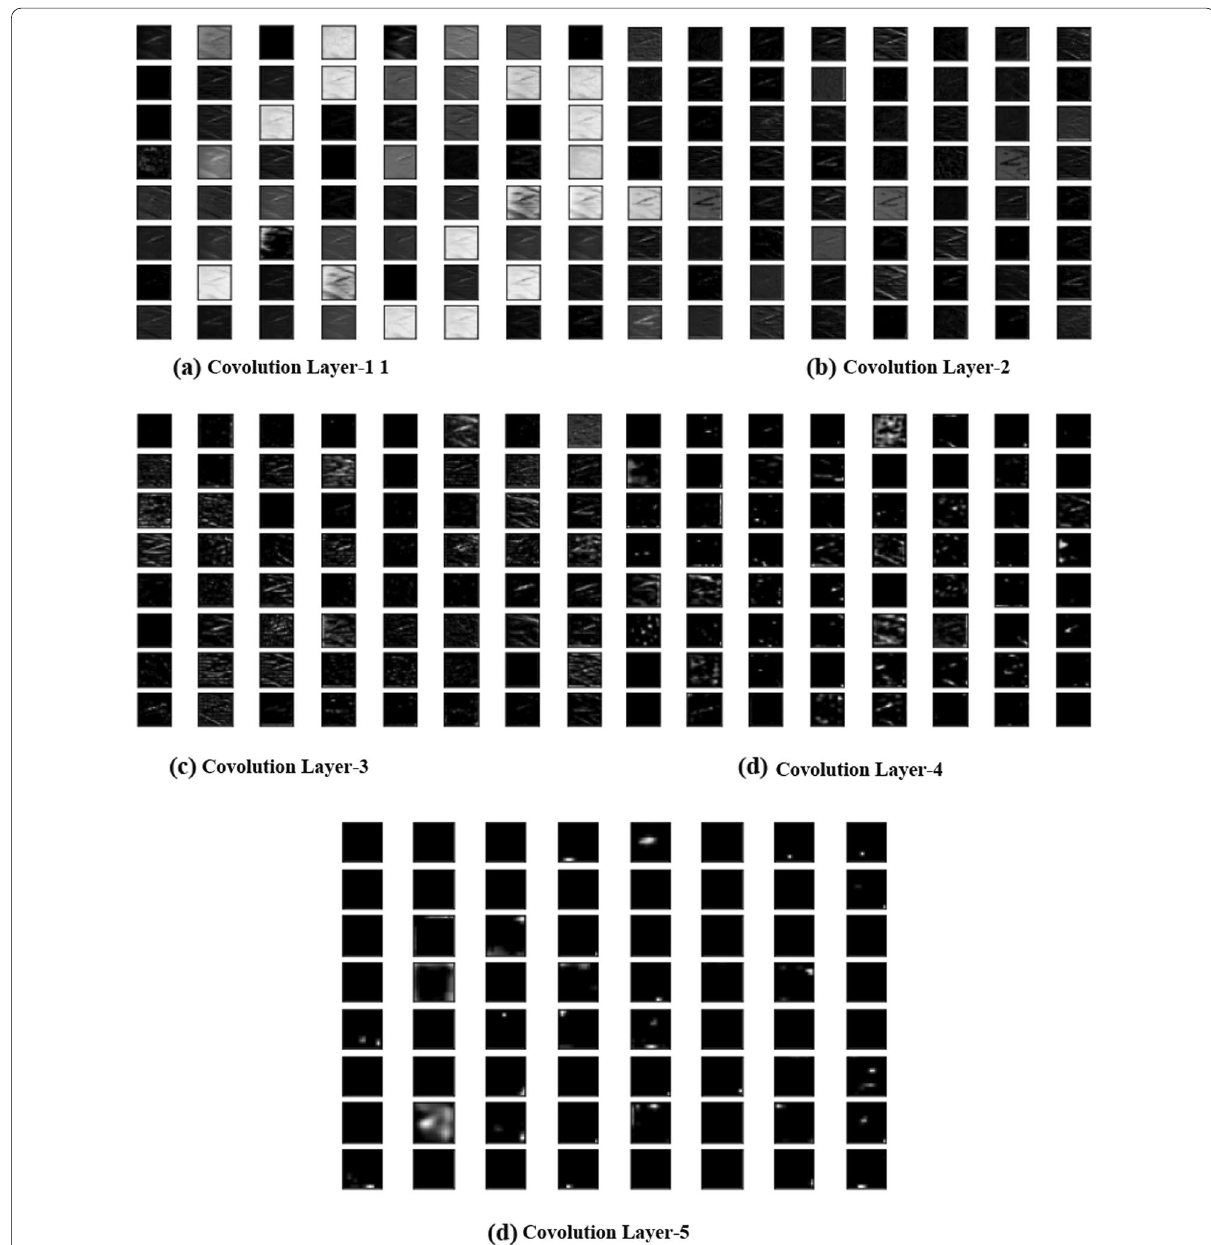
Fig. 8 Typical feature maps of Alexnet Deep Learning Convolutional Neural